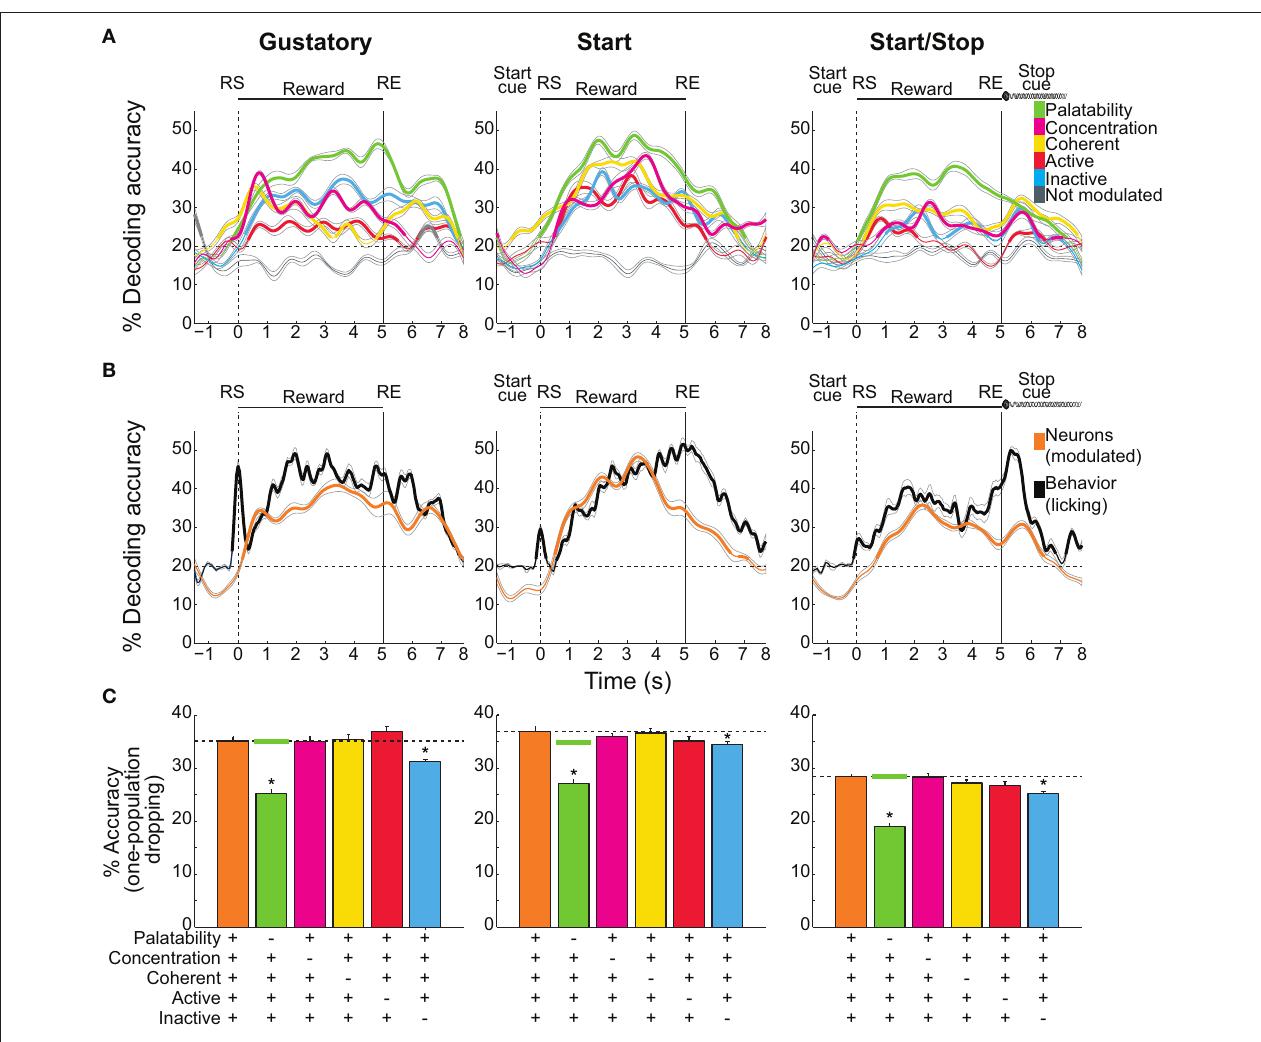
FIGURE 7 | Decoding accuracy of sucrose concentrations/palatability by different NAcSh populations. (A) The temporal decoding dynamics in the three brief-access tests of the five sucrose concentrations (palatability) achieved by the five distinct populations. A sixth group is comprised of neurons that do not belong to any population were named “Not modulated” (gray lines). Values are the average and sem of single trials that were correctly classified around RS (time = 0s). Thicker lines in all panels indicate significantly above chance level (for five stimuli = 20%, horizontal dashed lines) as ascertained by a one group right-tailed t-test ( p < 0.05). (B) The time course of the decoding accuracy of sucrose concentrations/palatability achieved by pooling all groups (all modulated neurons in orange) and the decoding reached by the licking responses per se (black; oromotor palatability). (C) Overall decoding during the Reward epoch (mean ± sem) in the three tests as a function of all the Modulated neurons (orange bars and horizontal dashed lines) and the same group but without the participation of each of the populations. Horizontal green lines are the average levels of decoding achieved by dropping (100 times) a random population of neurons as large as the Palatability population. *means significant differences with the Modulated population at the alpha level of